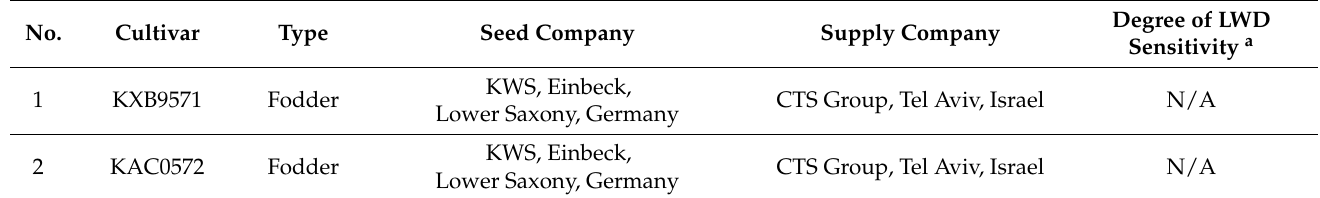
Table 1. Maize cultivars tested for late wilt disease